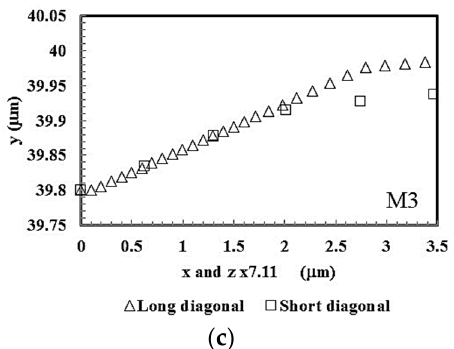
Figure 6. Surface indentation profiles at maximum load, obtained from the results of Figure 5a,c, where z is multiplied by R = 7.11, in order to easily compare the profiles along the two diagonals, the longer, L, and the shorter, m: ( a ) Material M1; ( b ) Material 2; ( c ) Material M3.